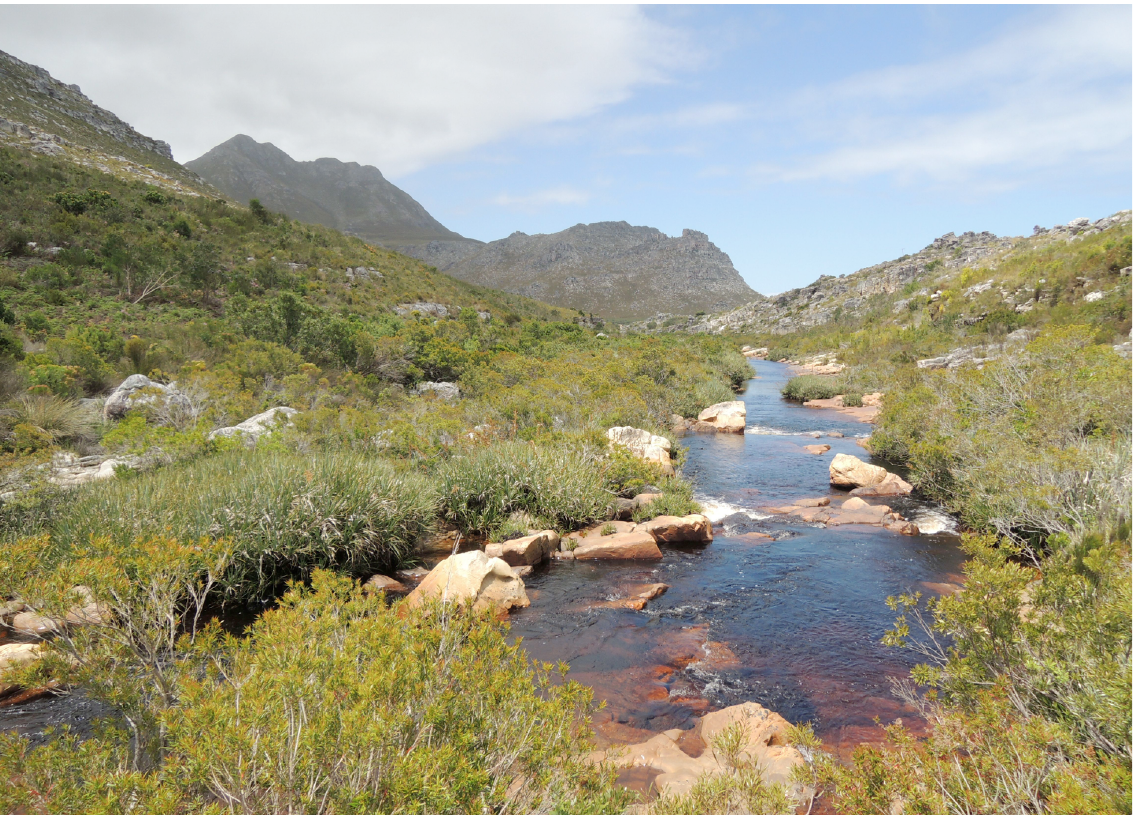
Fig. 1. South Africa, Western Cape Prov., banks of the Lower Palmiet River, the type locality of the new